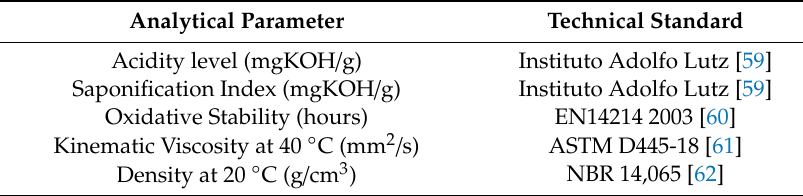
Table 8. Analytical parameters and technical standards used for the physicochemical characterization of residual babassu